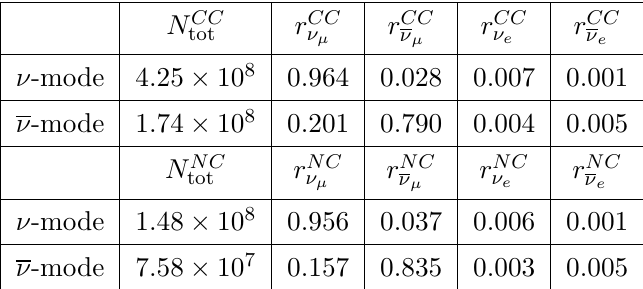
Table 5 . Number of charged- (CC) and neutral-current (NC) neutrino-nucleus scattering events in 3 + 3 years of operation of the DUNE ND. The fractional contribution to the total rate of the four contributing processes are also